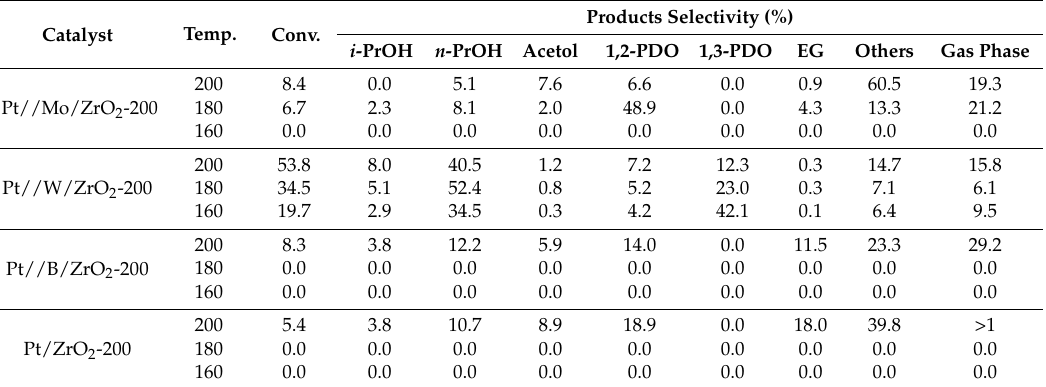
Table 2. Liquid-phase hydrogenolysis of glycerol at different temperatures. Conversion and selectivity to propan-2-ol ( i -PrOH), propan-1-ol ( n -PrOH), acetol, propane-1,2-diol (1,2-PDO), propane-1,3-diol (1,3-PDO), ethylene glycol (EG) and other reaction products. Catalyst Temp.